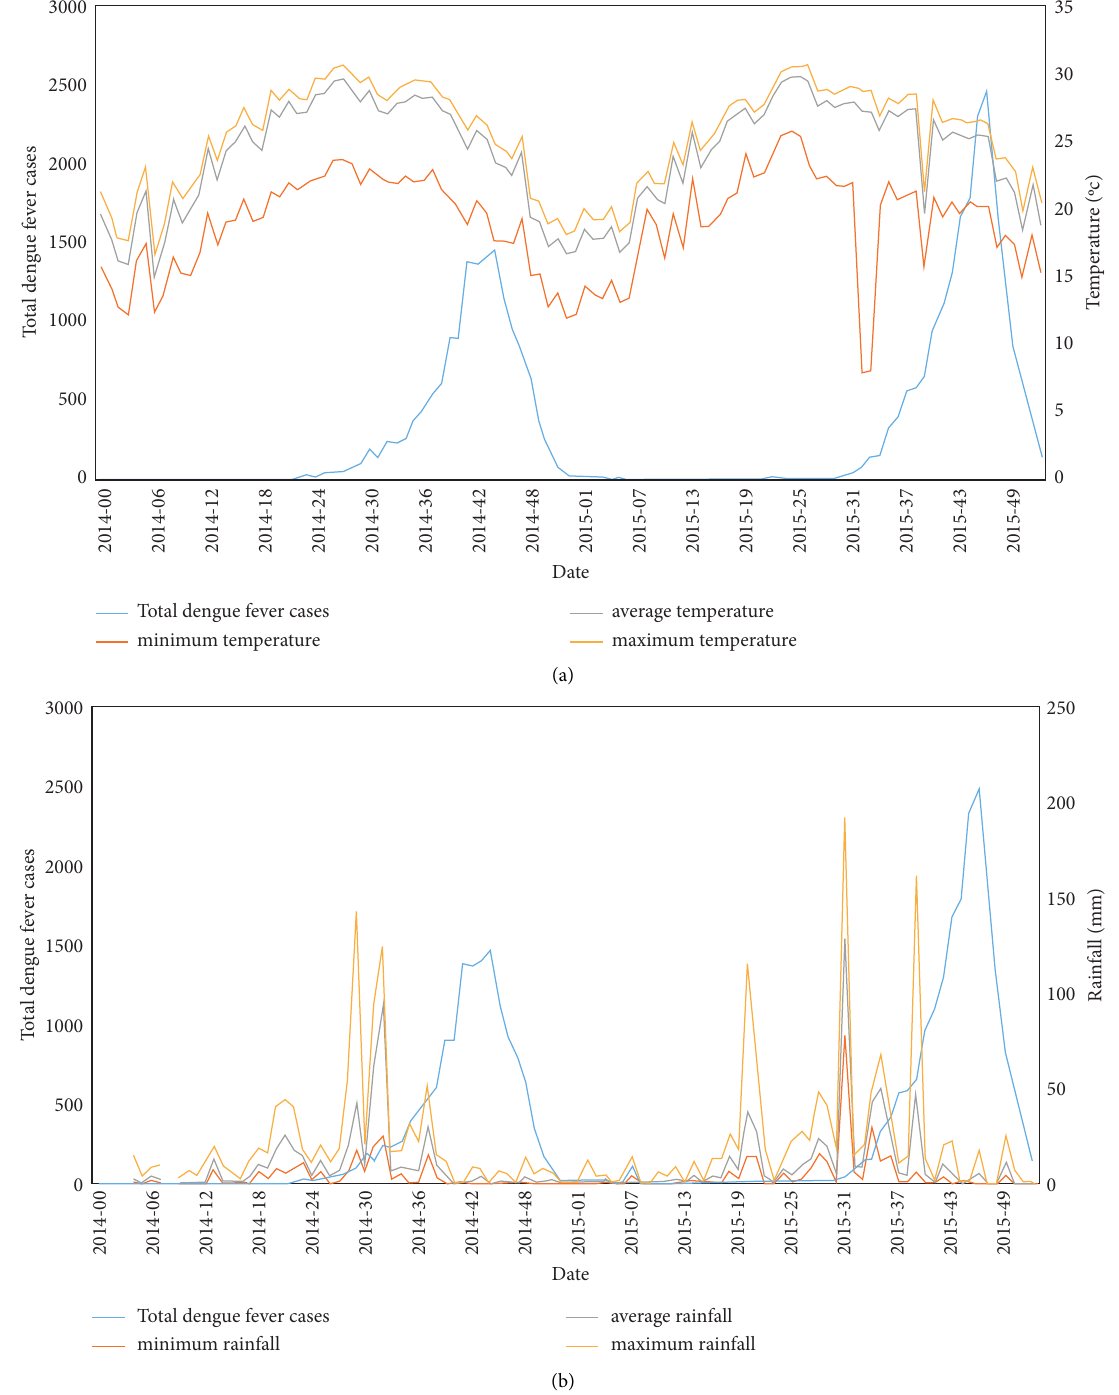
Figure 2: Time-series weekly average temperature (a) and rainfall measures (b) and total dengue fever cases from 2014 to 2015 in Kaohsiung